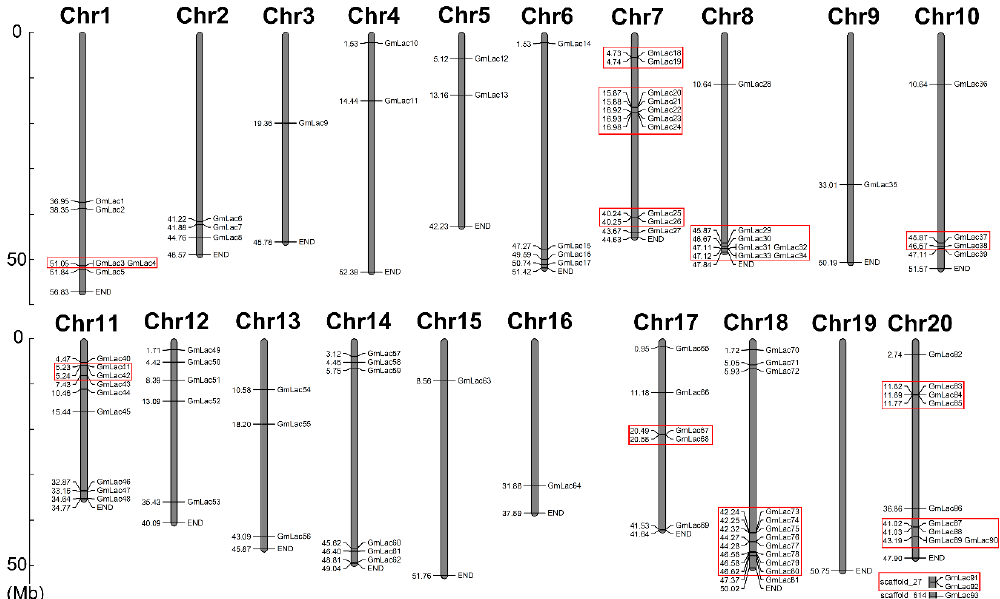
Figure 1. Physical map of the soybean laccase genes. Chromosome size is indicated by its relative length. The scale bar is shown on the left, and the numbers represent the physical position of the genes on the chromosomes. Tandemly duplicated genes are represented by boxes with red outlines.